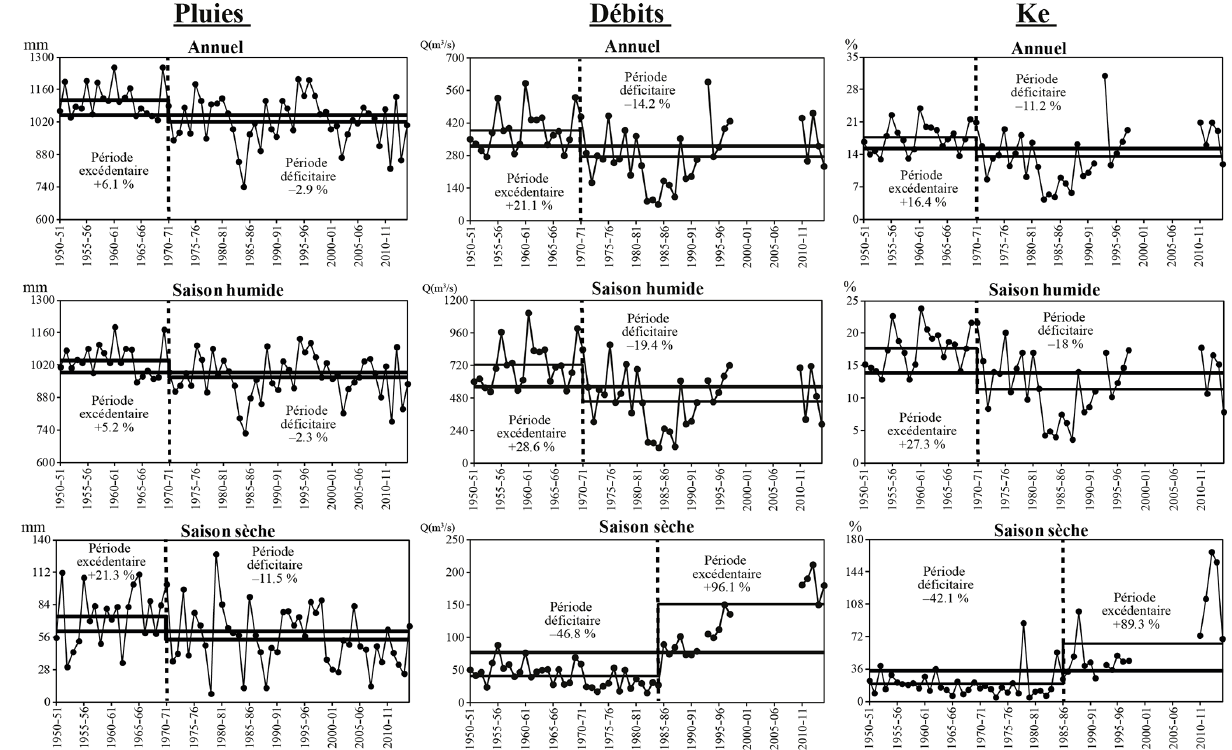
Figure 2. Evolution des pluies, débits et coefficients d’écoulement (Ke) annuels et saisonniers de la Bénoué entre 1950–1951 et 2014–2015.